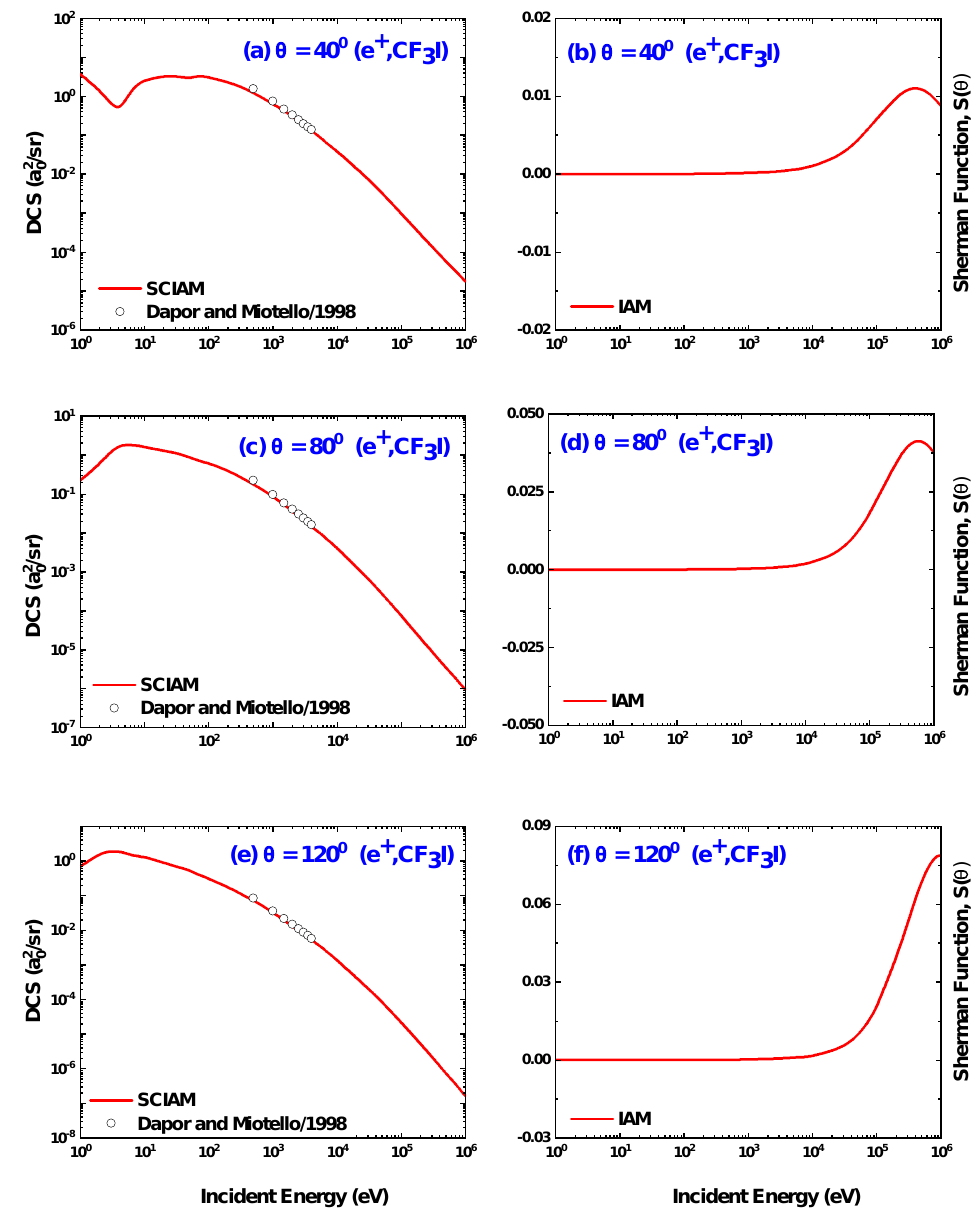
Figure 9. Energy-dependent DCS ( a 2 / sr ) and Sherman function at 40 ◦ , 80 ◦ , and 120 ◦ for the elastic 0 scattering of positrons from CF 3 I. Theoretical works: SCIAM (DCS), IAM (Sherman function), and Dapor and Miotello